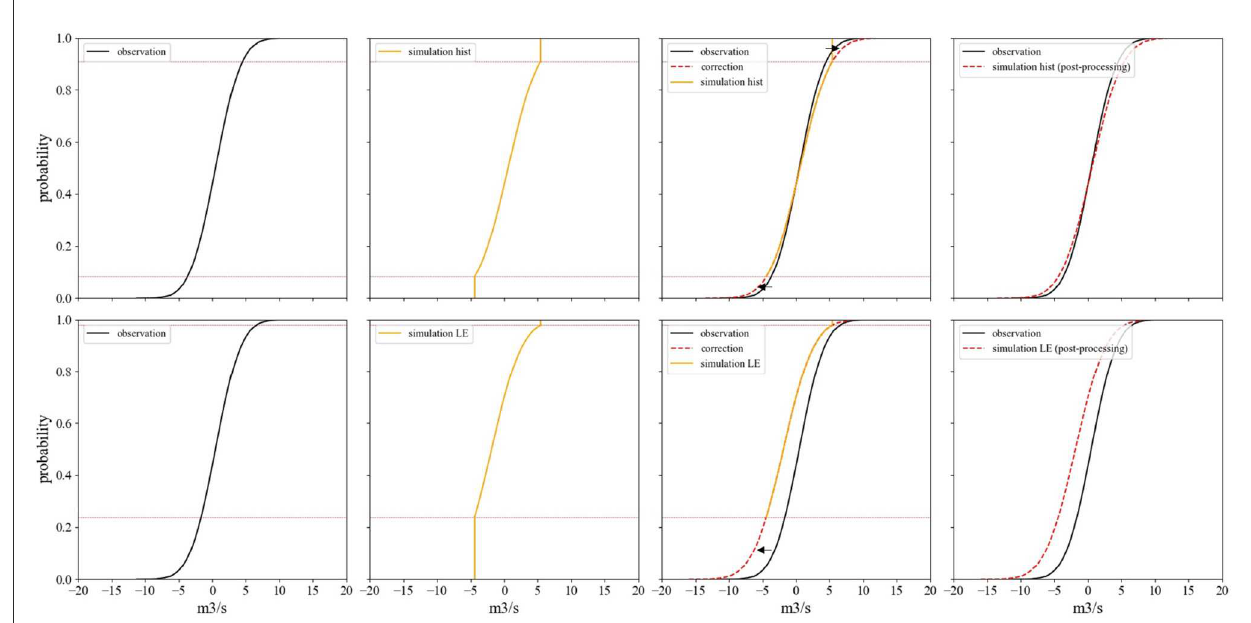
FIGURE1 Schematic of post-processing approach based on information of historical observation CDF (black), which is transferred to simulation results (orange) of historical simulations (top) and single ensemble member of simulated target variable based on LE data (bottom) . The information regarding tail of the distribution is transferred to simulation results by shifting and extrapolating the simulated tail (black arrow) to the shape of the historical observation one (indicated by red dotted line), resulting in a corrected target value (red, most right